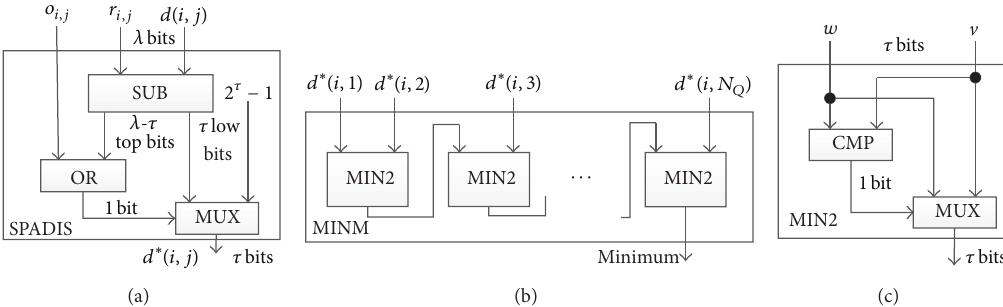
Figure 3: Structure of module SPADIS for Euclidean distance, MINM, and MIN2. (a) SPADIS, (b). MINM, and (c).